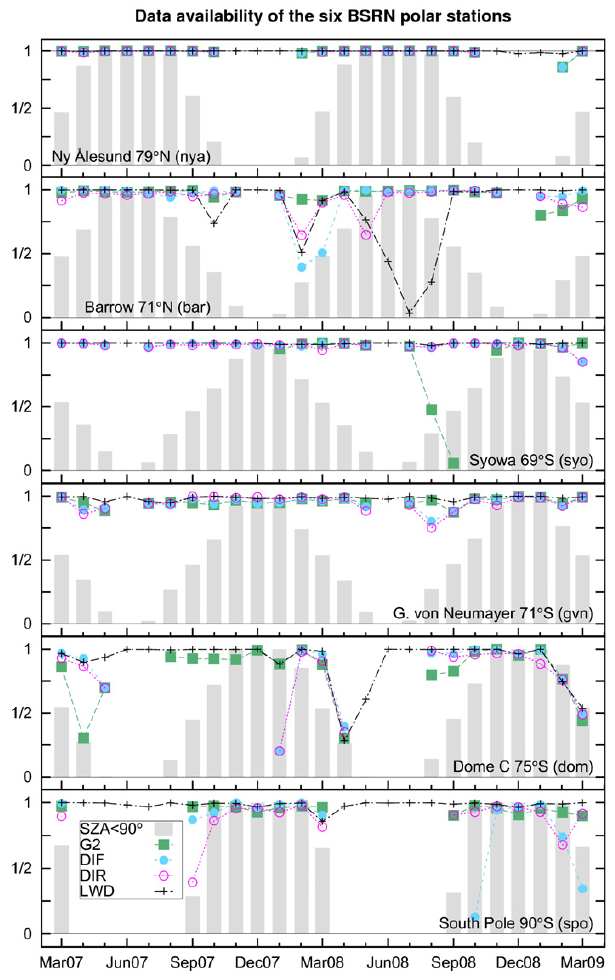
Figure 3. Monthly availability of the BSRN data for downwelling global shortwave (G2), direct (DIR), di ff use (DIF) and longwave downwelling (LWD) radiation components. The lack of a marker corresponds to lack of corresponding data. Fractions for shortwave components are calculated with respect to the daylight (SZA < 90 ◦ ), while for longwave with respect to all-day. Gray bars indicate the daylight fraction for various months of the IPY measurement period from March 2007 to March 2009.